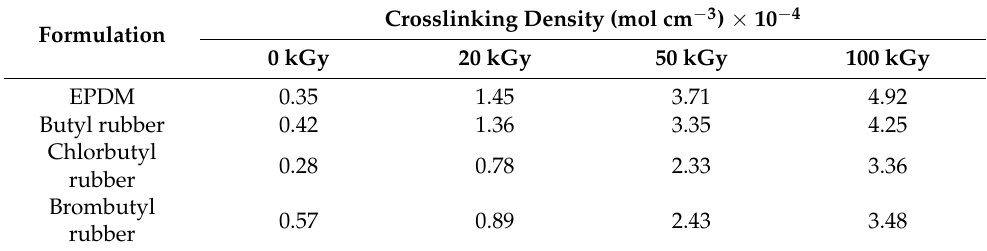
(Table 8). The involvement of crosslinker creates a hybrid conformity in the bulk of material. Table 8. Crosslinking density of some irradiated elastomers * [155].